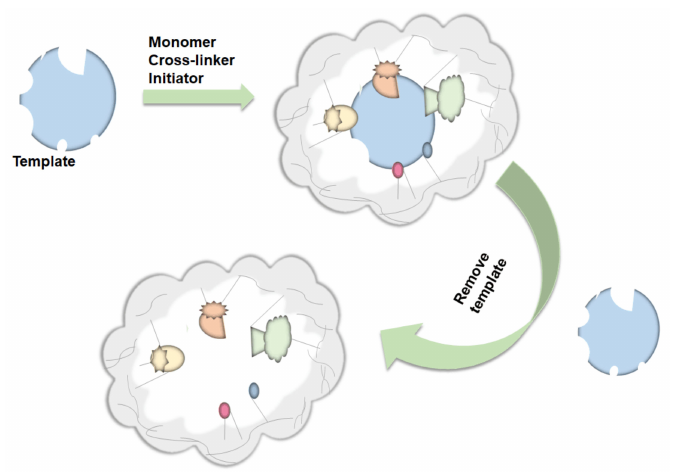
Figure 3. Procedure for preparing molecularly imprinted polymers